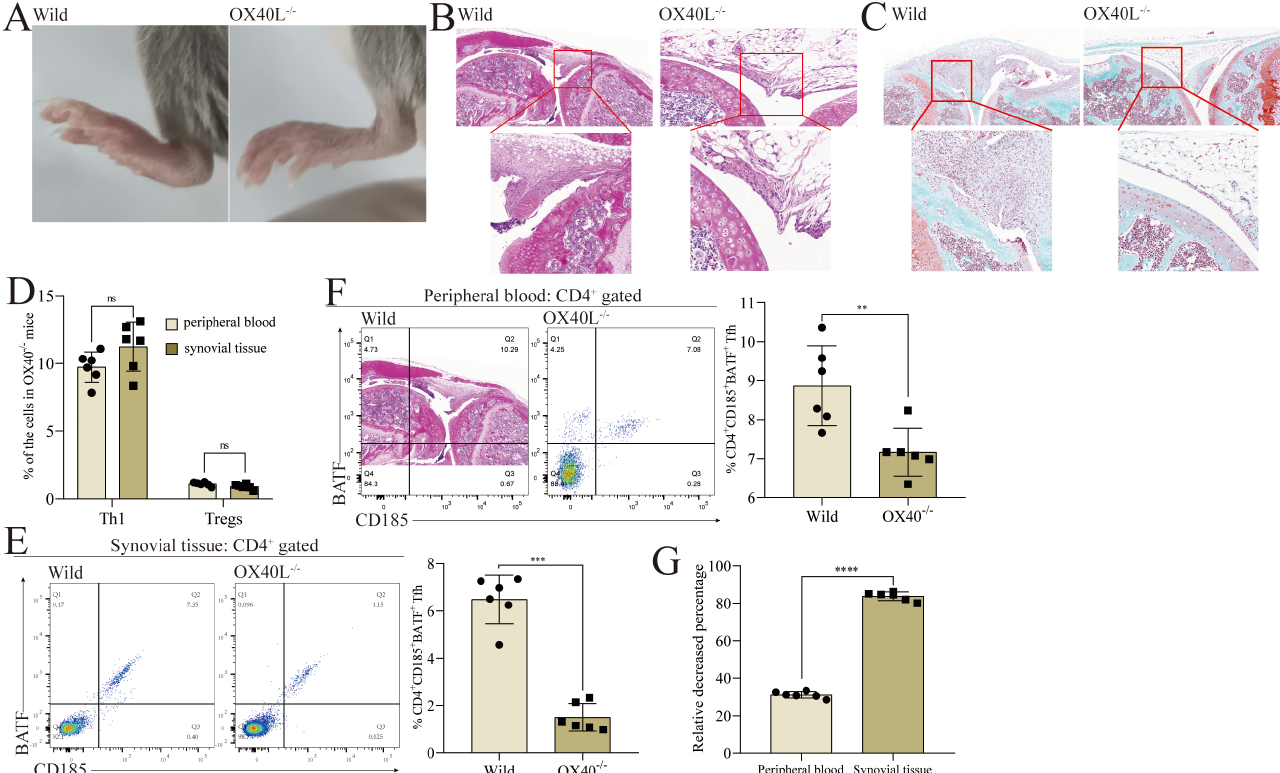
Figure 3. Tfh differentiation is dependent on the OX40/OX40L signaling in the joint microenvi- ronment in mice. ( A ) Collagen-induced arthritis model was established on wild-type mice and OX40L − / − mice. All mice were sacrificed on day 42. The picture shows the paw of the mouse on day 42. ( B ) HE staining of the knee in mice on day 42. ( C ) SafraninO-fast green staining of the knee in mice on day 42. ( D ) The proportion of CD183 + T-bet + Th1 and CD25 + Foxp3 + Tregs in CD4 + T cells in the peripheral blood and the synovial tissues of OX40L − / − mice. ( E ) The proportion of CD185 + BATF + Tfh in CD4 + T cells in the synovial tissues of wild-type and OX40L − / − mice. Left, scatterplot; right, histogram. ( F ) The proportion of CD185 + BATF + Tfh in CD4 + T cells in the periph- eral blood of wild-type and OX40L − / − mice. Left, scatterplot; right, histogram. ( G ) Comparison of the proportion of CD185 + BATF + Tfh in CD4 + T cells in the peripheral blood and the synovial tissues. In ( E , F ), ** p < 0.01 and *** p < 0.001 represent a significant difference between the wild-type group and the OX40L − / − group. In ( D , G ), **** p < 0.0001 represents a significant difference between the peripheral blood group and the synovial tissue group, and ns means no significant difference. Data represent mean ± SD (unpaired t test was